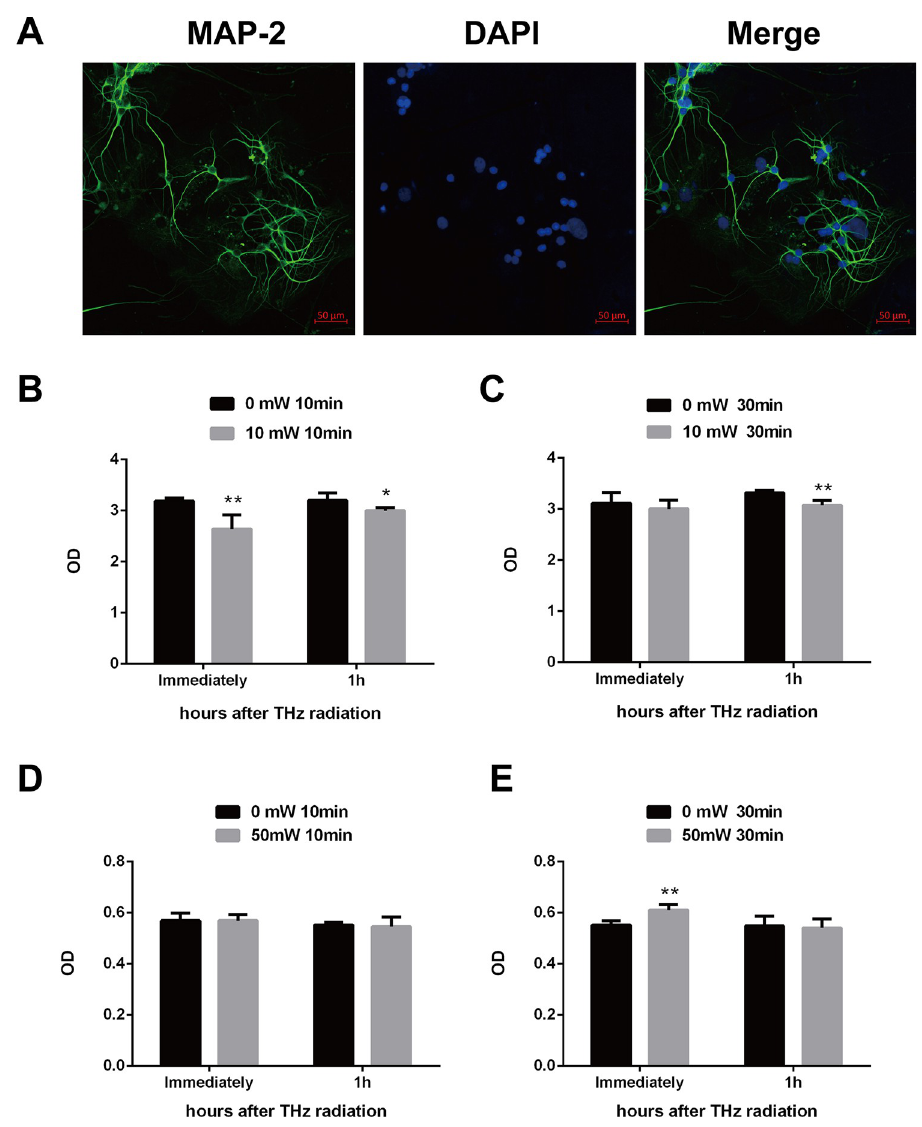
Fig 1. Effect of terahertz radiation on activity of the primary hippocampal neuron. Primary rat hippocampal neurons were isolated and cultured as described in materials and methods. (A), primary hippocampal cells showing neuronal staining with MAP2 (green). Nuclei were stained with DAPI (blue) (scale bar = 50 μ m). Cellular activity was measured by CCK-8 assay immediately or 1 h after indicated terahertz radiation. The cellular activities were shown in B and C after exposure to 0.12 THz with power of 10 mW for 10 min and 30 min, respectively. Moreover, cellular activities were also presented in D and E after radiated by 0.157 THz with power of 50 mW for 10 min and 30 min respectively. Sham-radiated cells under the same conditions were used as the controls. Three independent experiments were conducted. Data were shown as mean ± s.e.m. � p < 0.05, �� p < 0.01 vs corresponding group.